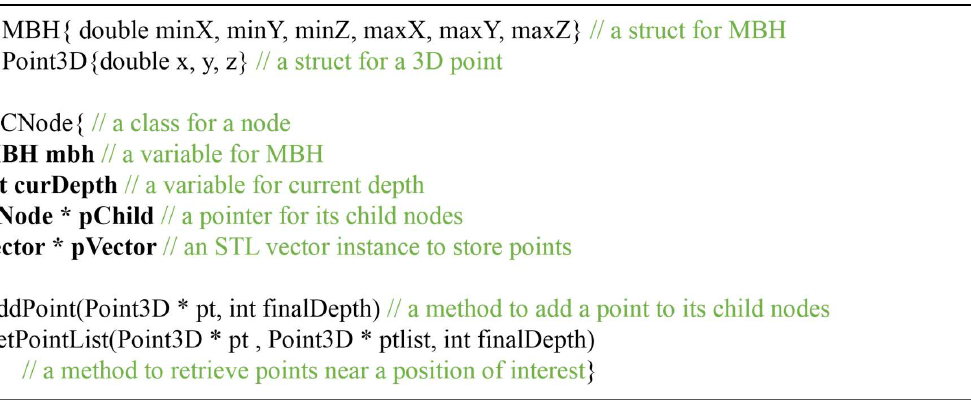
Figure 1. Pseudo codes of a basic form CNode.